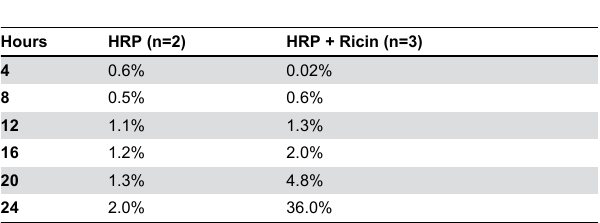
Table 1. Analysis of Horseradish Peroxidase (HRP) Detected in the Basolateral Chamber of Transwells.